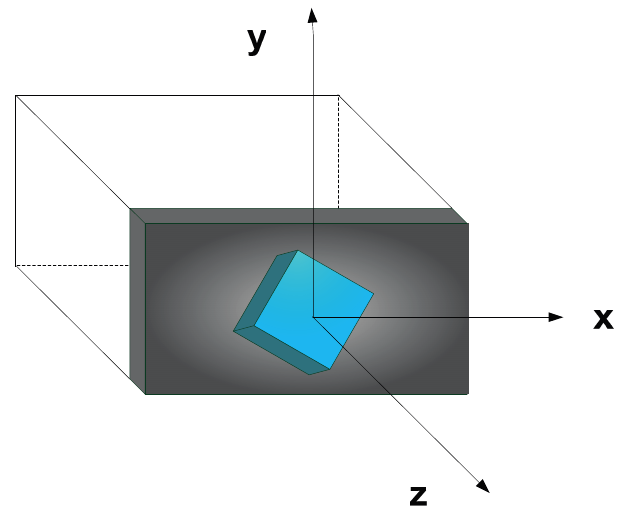
Figure 6. Display right hand coordinate system: screen lies along the plane z = 0, x- axis pointing to the right, y pointing to the vertical direction and z- axis out of the screen.